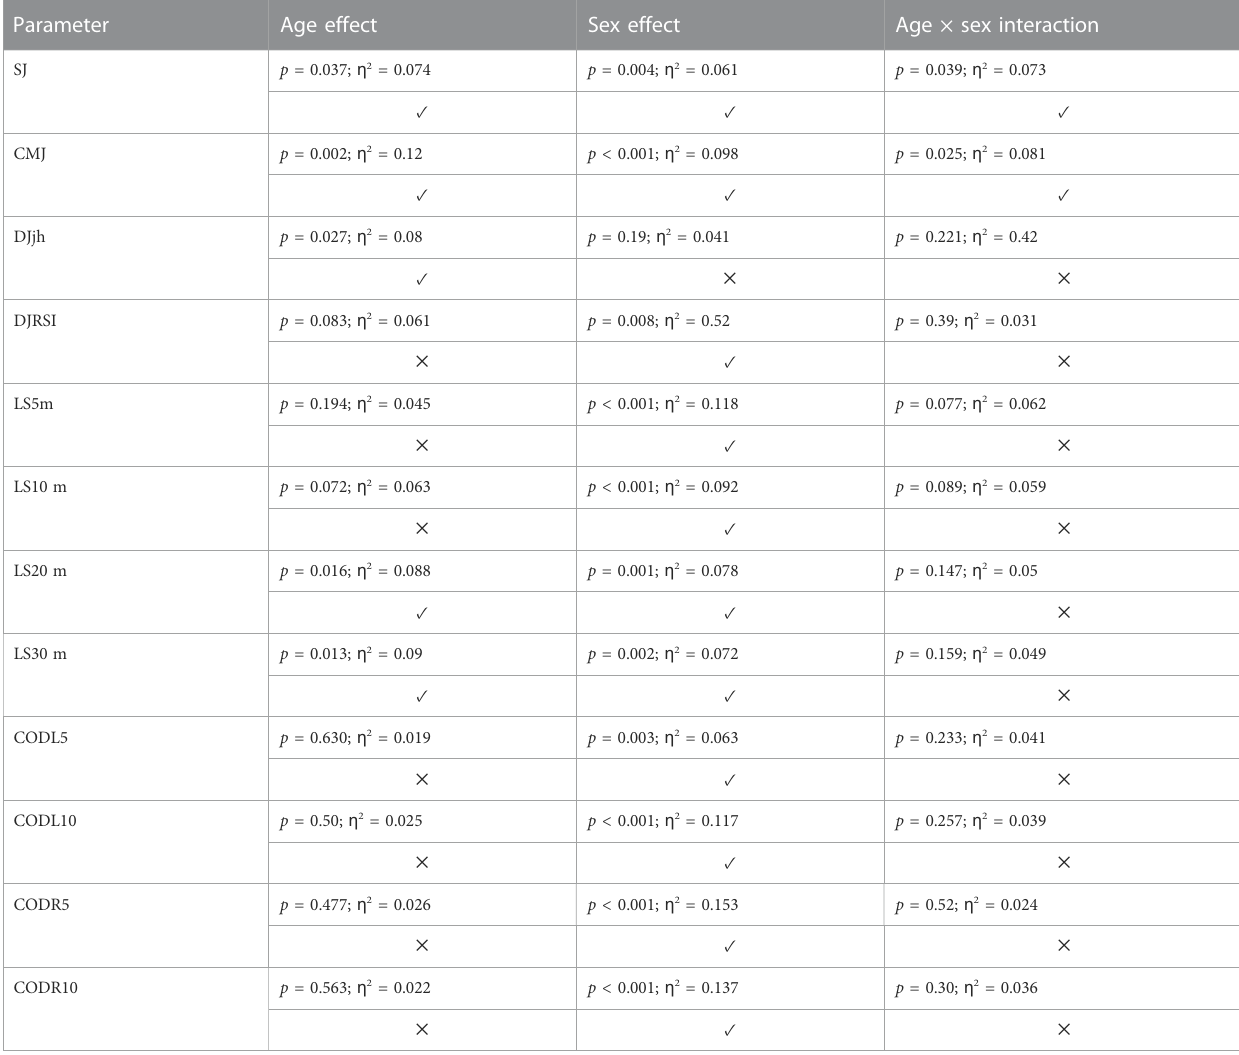
TABLE 2 Results of mixed-model ANOVA to determine age- and group-speci fi c differences.